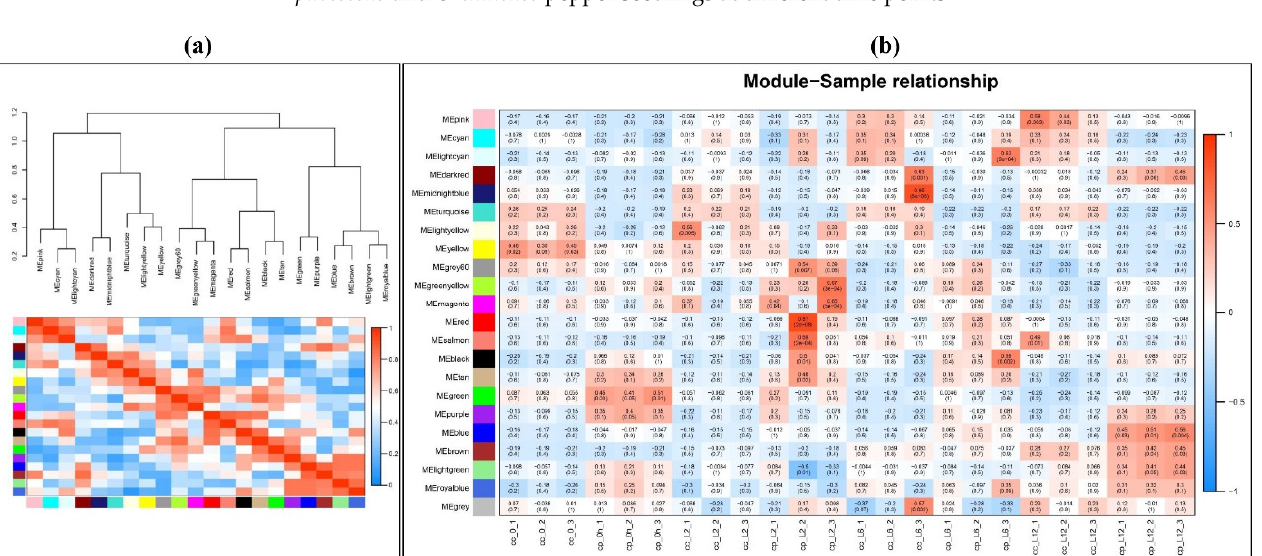
Figure 2. Summary of the RNA-seq results ( a ) The overall number of upregulated and downregulated genes in the cold-treated C. pubescens and C. chinense pepper seedlings at different time points ( b ) Venn diagram representation of commonly expressed genes in different comparisons of cold-treated C. pubescens and C. chinense pepper seedlings at different time points.